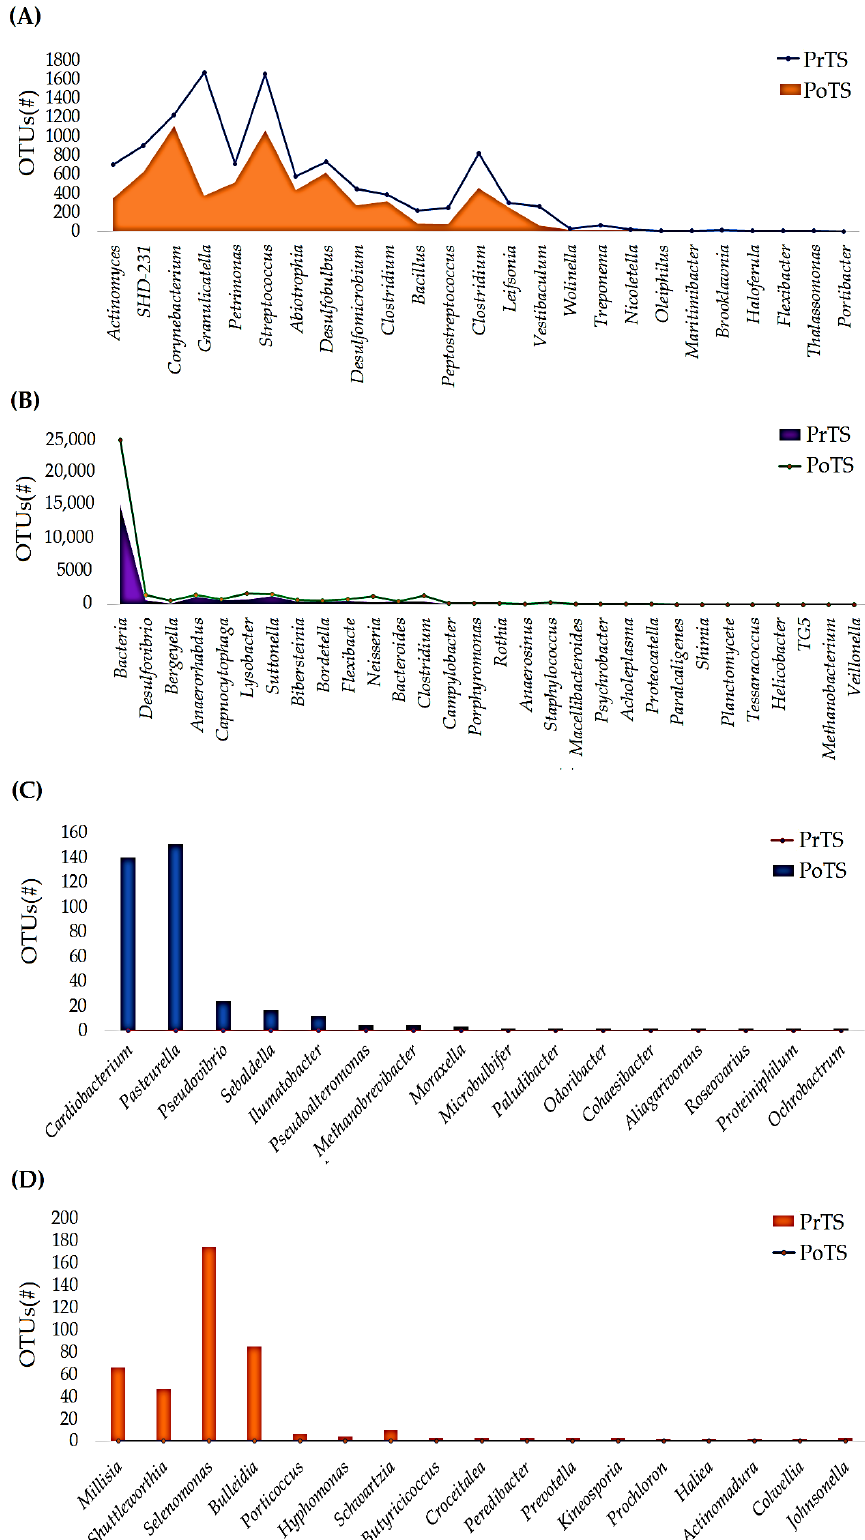
Figure 5. Comparison of the genus-level relative frequency of the PrTS and PoTS of G2. The reduced ( A ), increased ( B ), newly evolved ( C ), and completely vanished ( D ) genera in the control group after 42 days of study were reported. PrTS: pretreatment samples; PoTS: post-treatment samples.